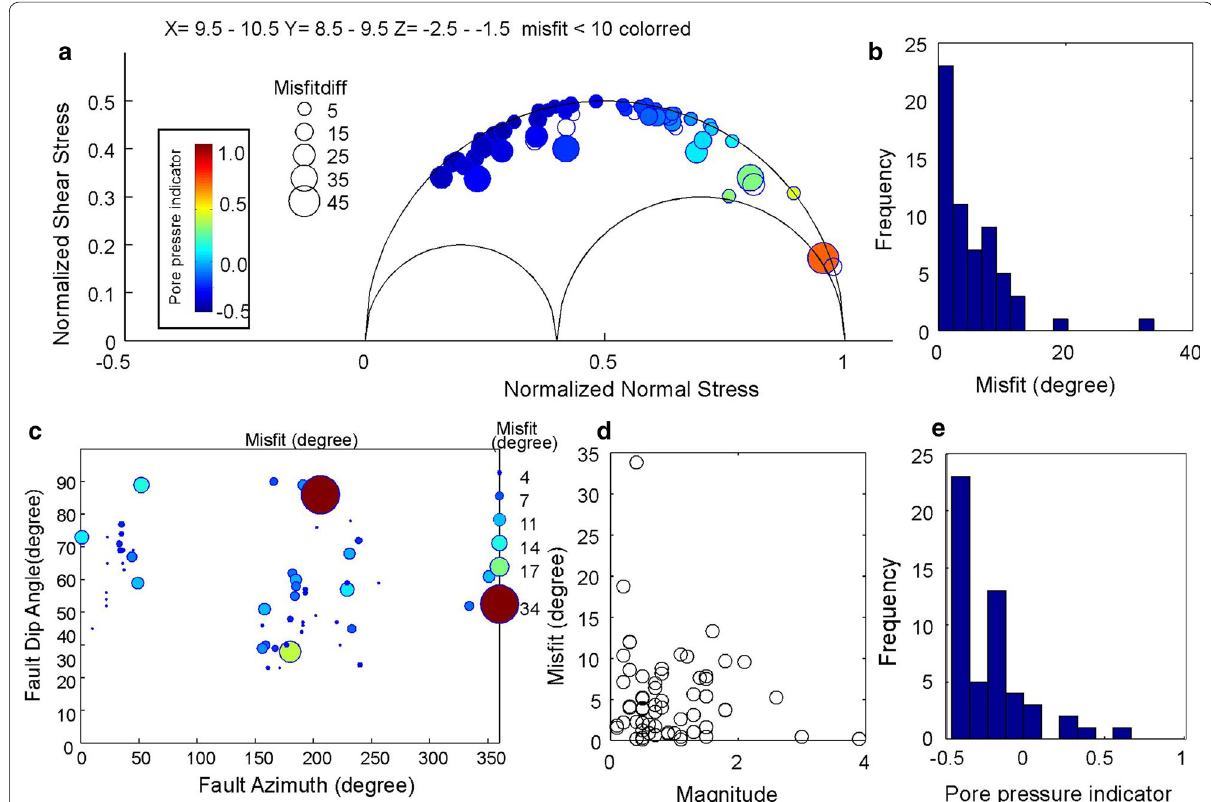
Fig. 12 a Plots of the normalized shear and normal stresses on a three-dimensional Mohr diagram for a grid point ( x gram of misfits. c Relationship between azimuths and dip angles of the fault planes. d Relationship between magnitude and misfit. e Histogram of the pore pressure indicator P p . Other explanations are the same as for Fig. 10. The following figure is that for Fig.